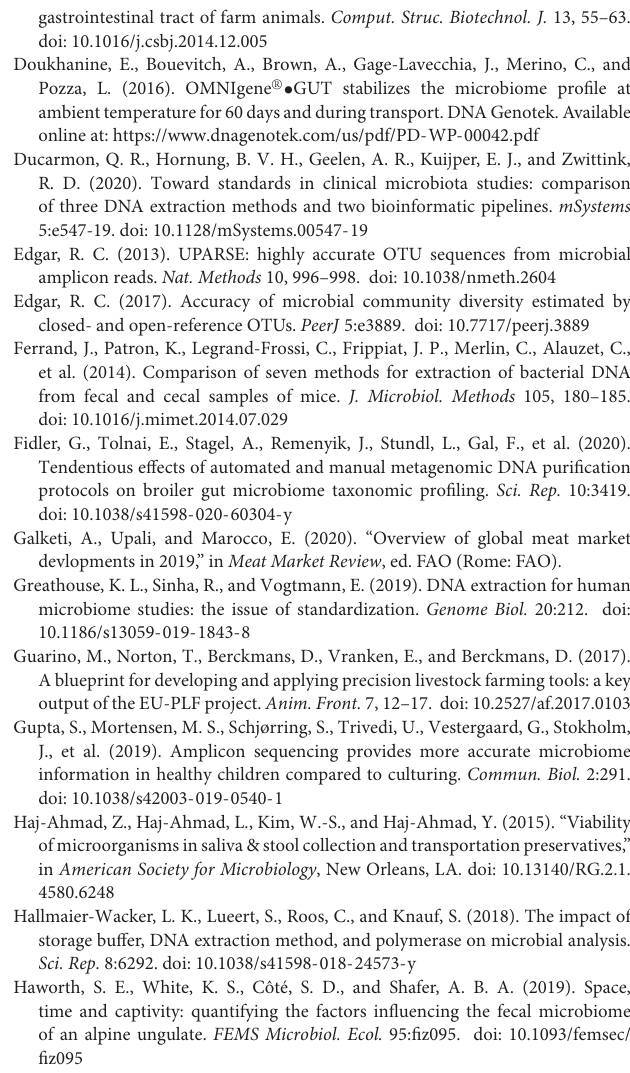
negative log-fold change indicates a reduction in abundance over time compared to the freshly extracted samples group in chicken cecum, chicken feces, pig ileum, and pig feces samples. F: Freshly extracted, M: frozen at − 80 ◦ C, N: NAP buffer, O: OMNIgene-GUT buffer, R: RNALater, Z: ZYMO DNA/RNA Shield. Supplementary Data File 1 | Supporting information tables including (1) Metadata information on the samples used in the study. (2) Information on the purity of DNA extracted in Phase 1, based on 260/280 index. (3) Information on the purity of DNA extracted in Phase 2, based on 260/280 index. (4) Information on the total cell count per gram of digesta material measured by Flow Cytometry. (5) Details of the OTU that exhibited significantly increased/decreased abundances in the chicken cecum digesta stored in different storage media compared to freshly extracted chicken cecum digesta. (6) Details of the OTU that exhibited significantly increased/decreased abundances in the chicken feces samples stored in different storage media compared to freshly extracted chicken feces. (7) Details of the OTU that exhibited significantly increased/decreased abundances in the pig ileum digesta stored in different storage media compared to freshly extracted pig ileum digesta, and (8) Details of the OTU that exhibited significantly increased/decreased abundances in the pig feces samples stored in different storage media compared to freshly extracted pig